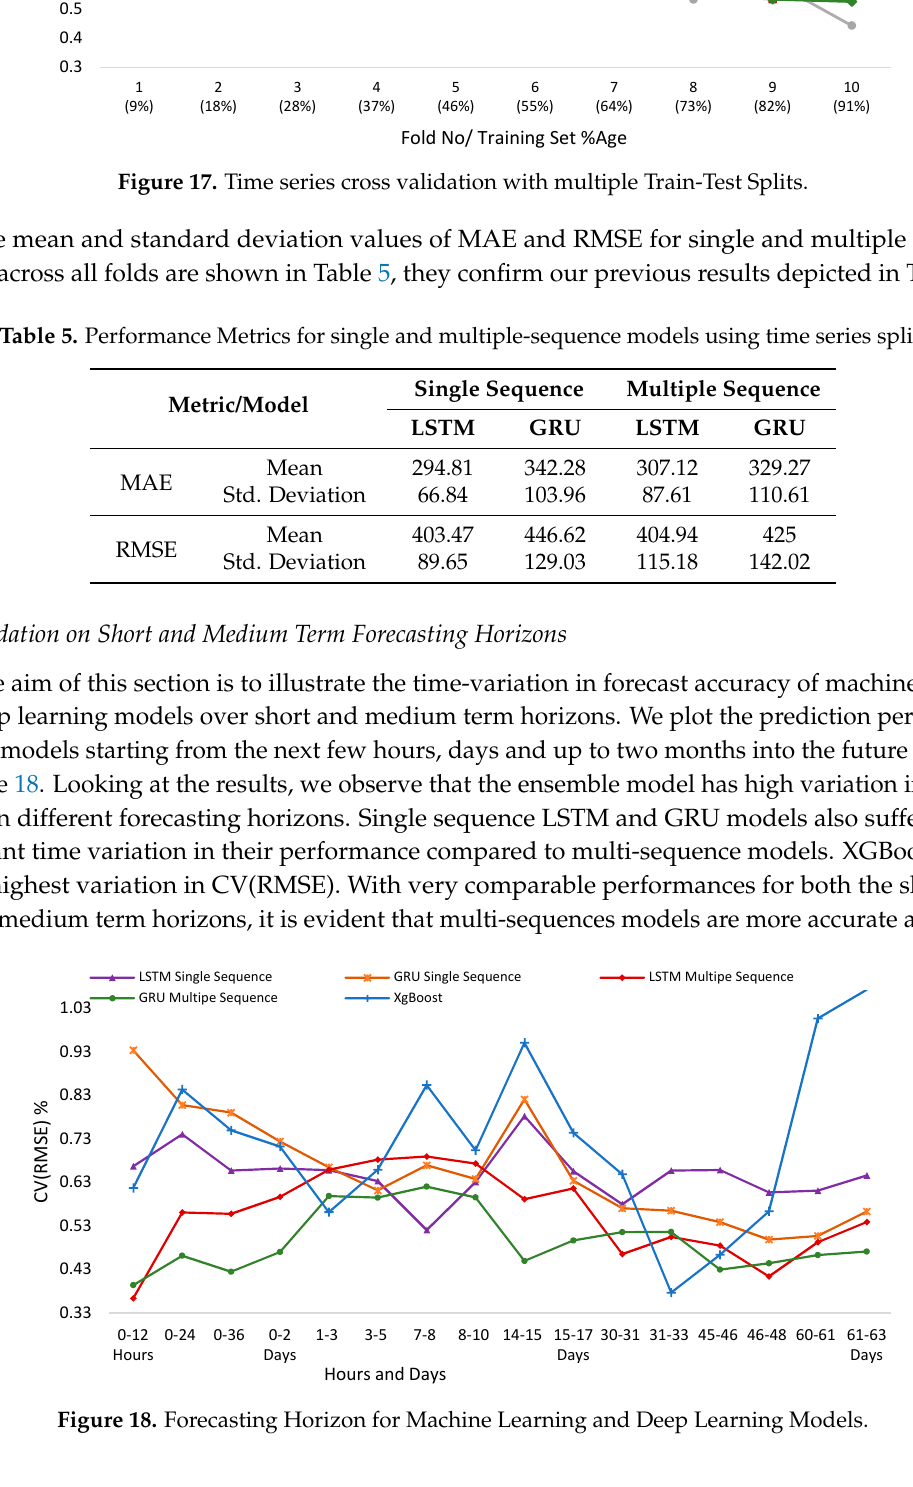
Figure 18. Forecasting Horizon for Machine Learning and Deep Learning Models.